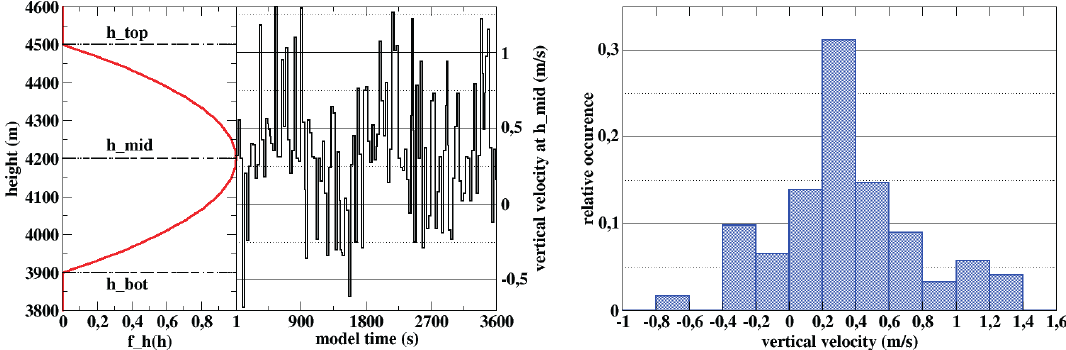
Figure 8. Vertical velocity field of the inner cylinder for case 1. Left: height dependence (red line) and temporal evolution of one realization of the stochastic vertical velocity field (black line) for w ave = 0 . 3ms − 1 at h mid . Right: histogram of velocity field. Vertical velocity for case 2 is identical but for heights between 7100 and